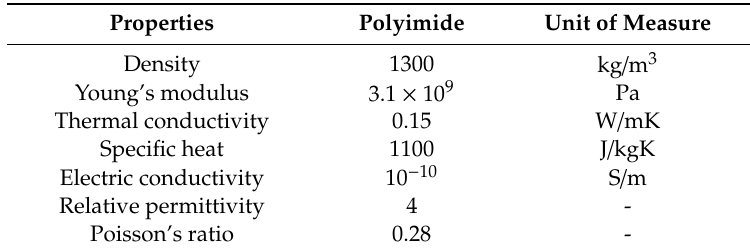
Table 5. Polyimide properties.